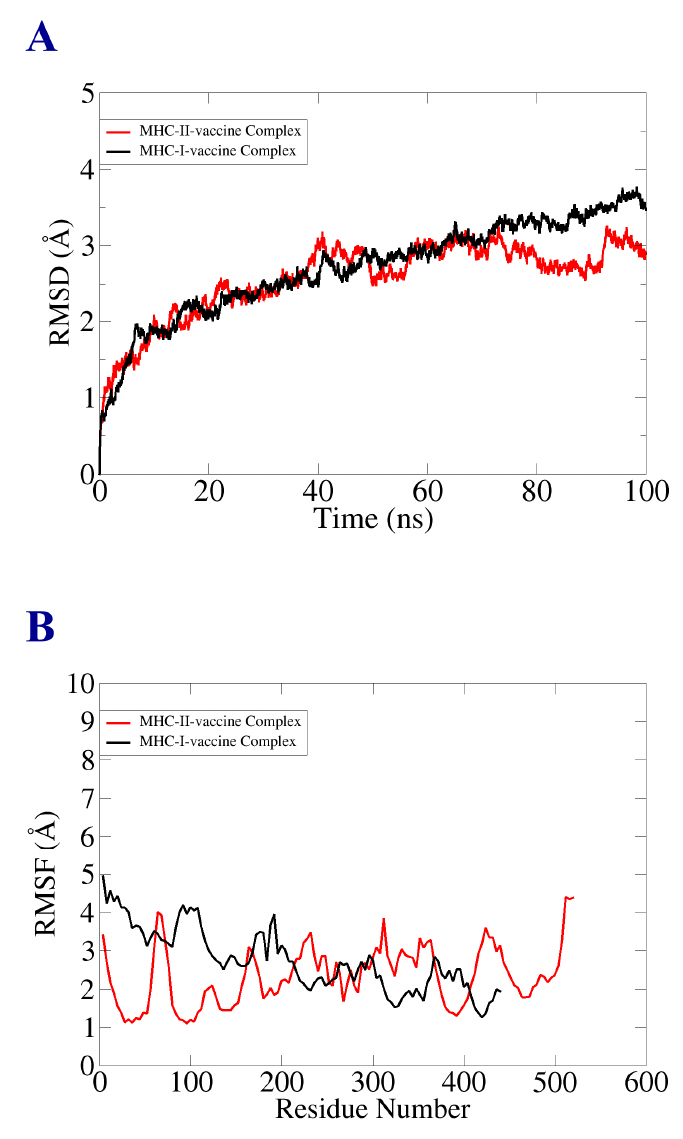
Figure 8. Statistical analysis of simulation trajectories. ( A ) RMSD plot; ( B ) RMSF plot.